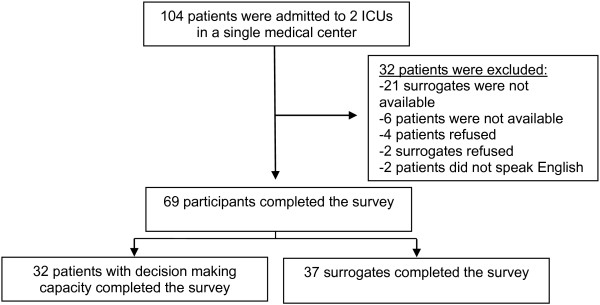
Study enrollment.